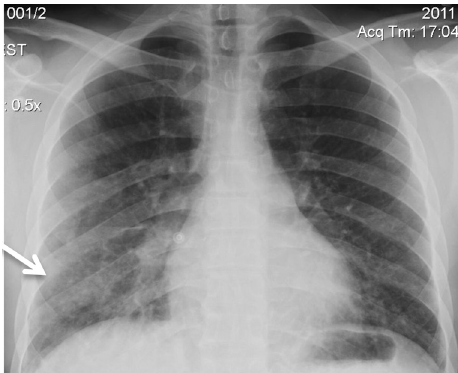
Figure 1. Chest radiograph of Patient 1 on presentation shows pulmonary edema and right lower lobe infiltrate